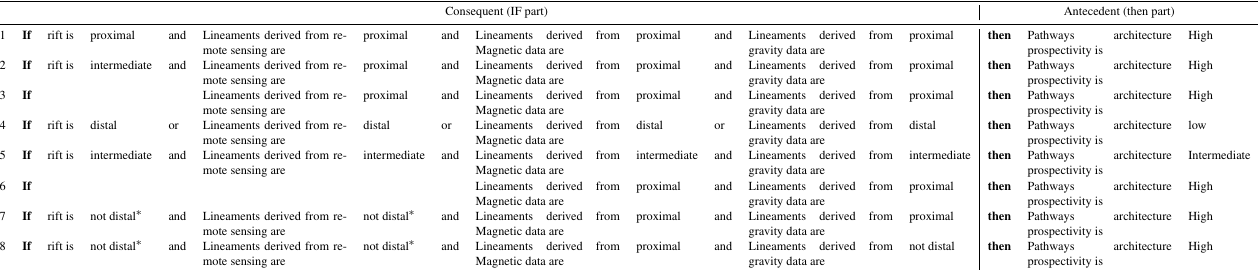
Table A3. Fuzzy if–then rules used for generating fuzzy prospectivity maps for favourable lithospheric architecture for transportation of REE-enriched carbonatite–alkaline